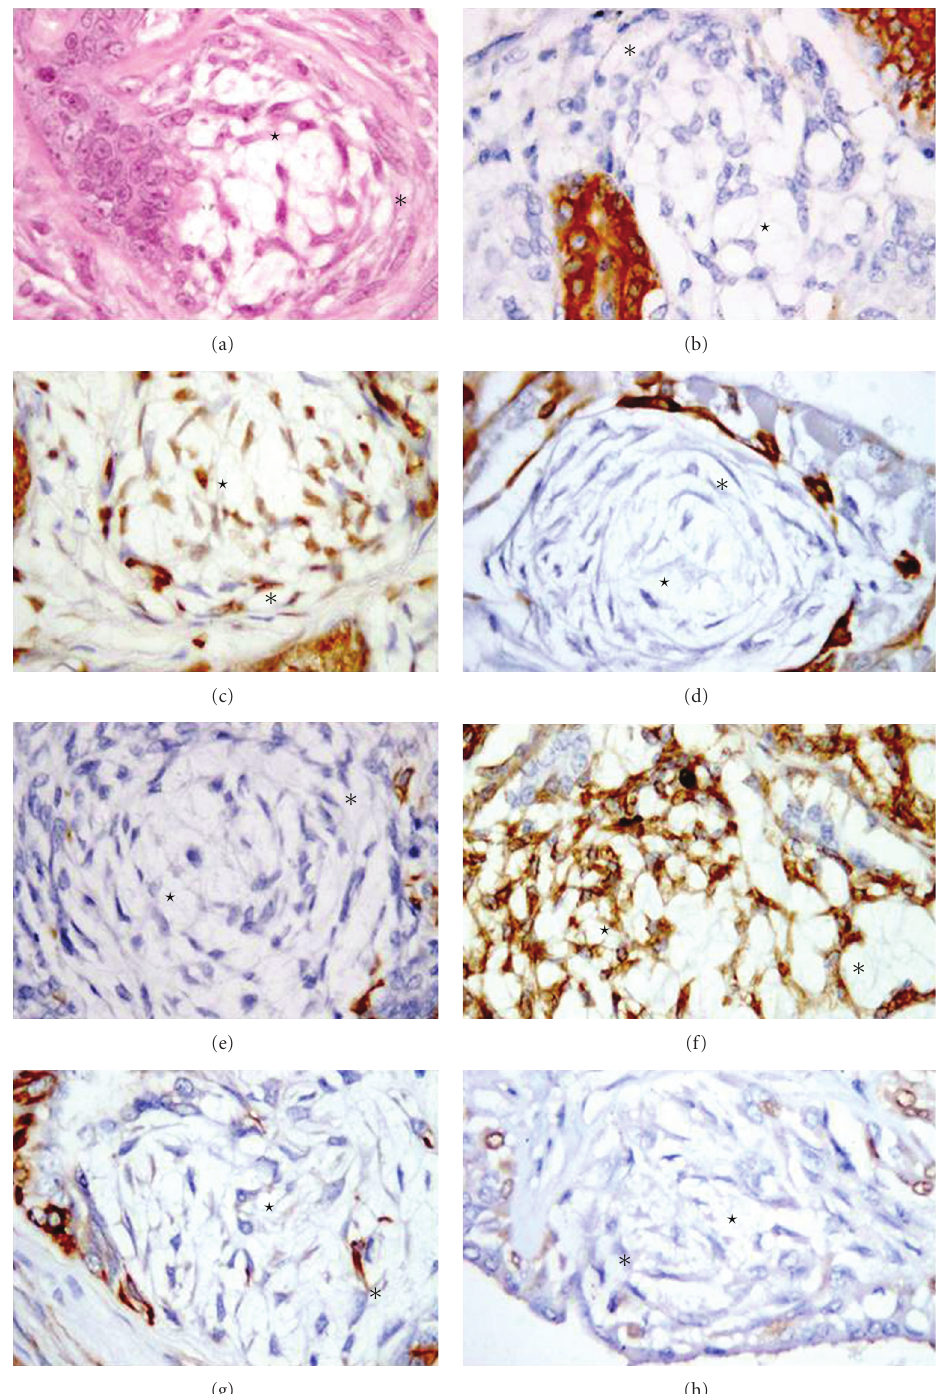
Figure 2: Motile myoepithelial cells: spindle (asterisks) and stellate (stars) cells. Immunohistochemical expression of a panel of antibodies applied by IHC. 63x (a) Hematoxylin-eosin; (b) anti-CK19 antibodies labeling the cytoplasm; (c) anti-ER antibodies labeling the nuclei; (d) anti-CK 5/6 antibodies labeling the cytoplasm; (e) anti-CK14 antibodies labeling the cytoplasm; (f) anti-VIM antibodies labeling the cytoplasm; (g) anti-Alpha-SMA antibodies labeling the cytoplasmic membrane; (h) anti-p63 antibodies labeling the